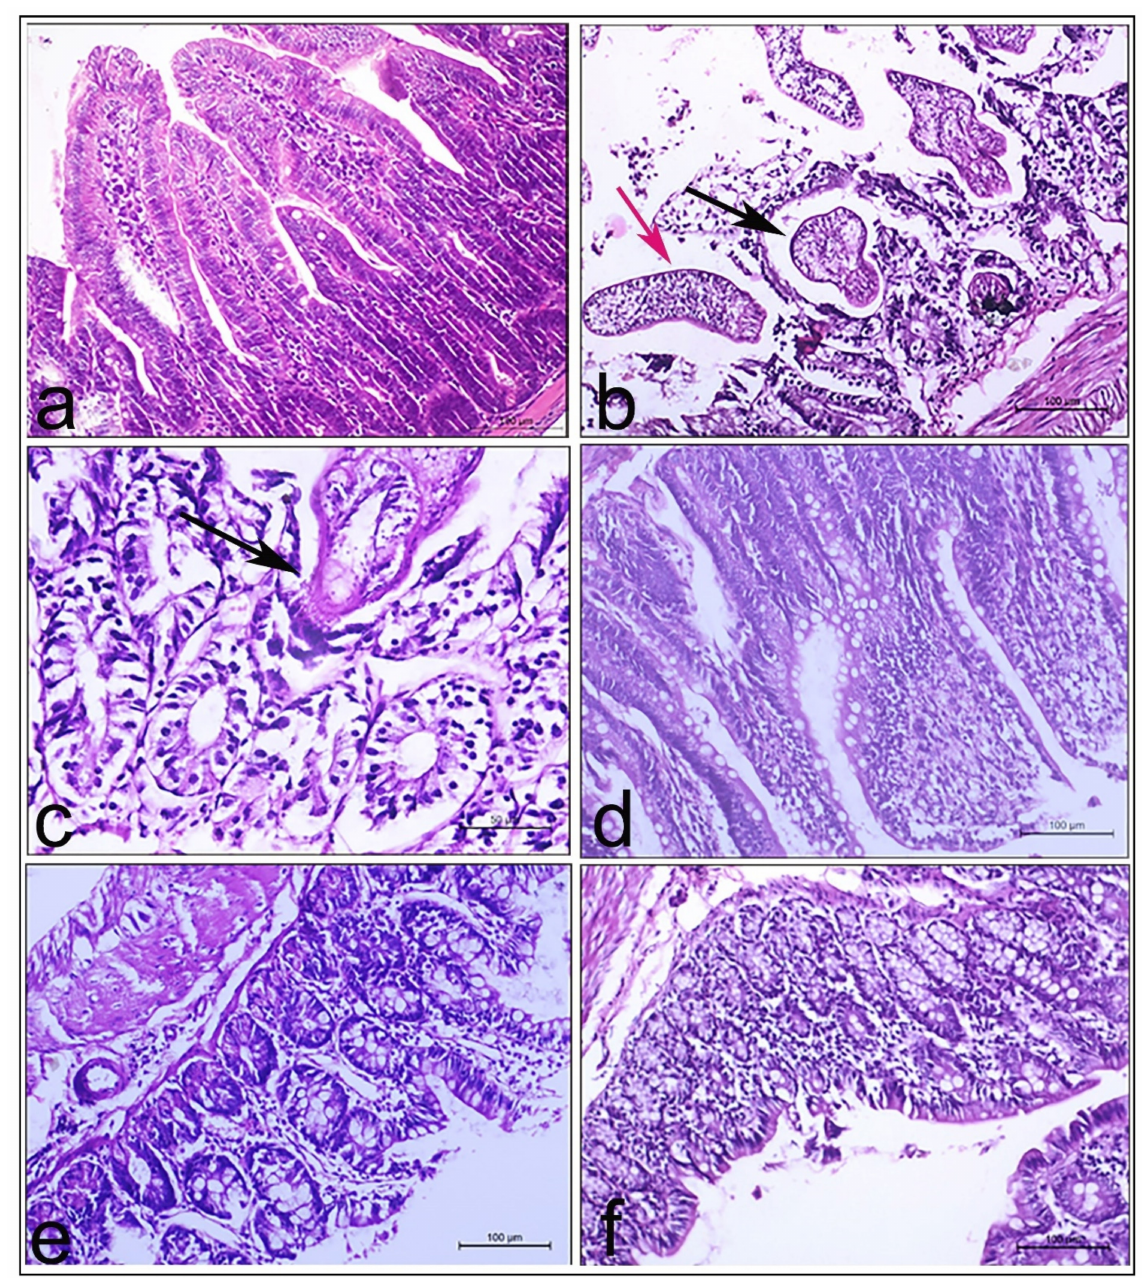
Figure 5. Representative intestinal sections of rats from all groups. ( a – f ): intestinal tissues stained with Hematoxylin and Eosin (H&E). Magnification × 100. ( a ) normal control group showed the normal intestinal villi and crypts. ( b ) intestinal section of infected non-treated control group man- ifested cysticercoid (black arrow) and immature worms (red arrow) surrounded by mononuclear cells infiltration. ( c ) crude PRZ (12.5 mg/kg) treated group revealed parasitic sections attached to the intestinal mucosa (arrow). ( d – f ) PRZ-PMMs (12.5 mg/kg), crude PRZ (25 mg/kg) and PRZ- PMMs (25 mg/kg) treated groups, respectively, presented variable degrees of submucosal parasitic granulomatous reaction associated with no parasitic